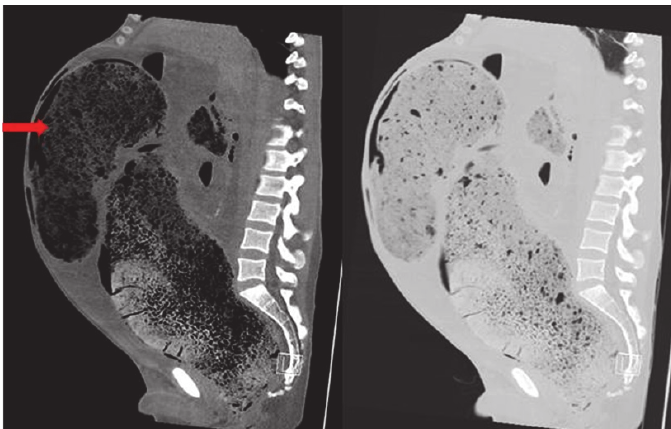
Figure3:SagittalMPRCTimageswithsofttissuewindowsontheleftandlungwindowsontheright.Thereisgrosschroniccolonicdistension with faecal loading down to the low rectum. The arrow shows faeces in a capacious sigmoid colon. No free gas on the film.